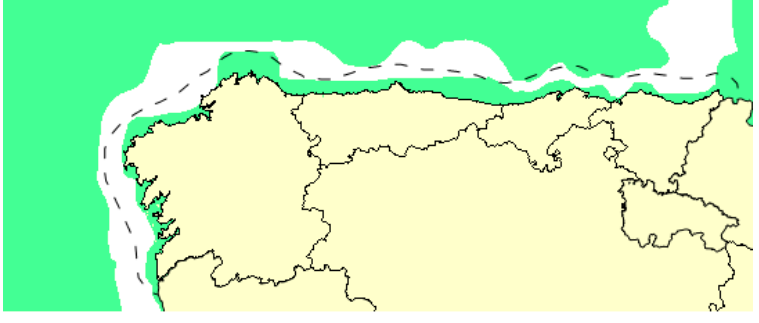
Figure 6. Bathymetry restriction.